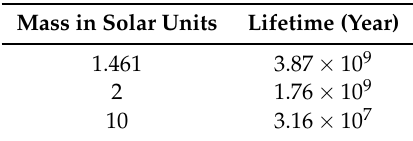
Figure 4. Double truncated Lindley PDF with parameters as in Table 1 and variable x u ; x u = 1.461 (red full line), x u = 2 (blue dashed line) and x u = 10 (green dotted line). Table 2. Lifetime of MAIN V